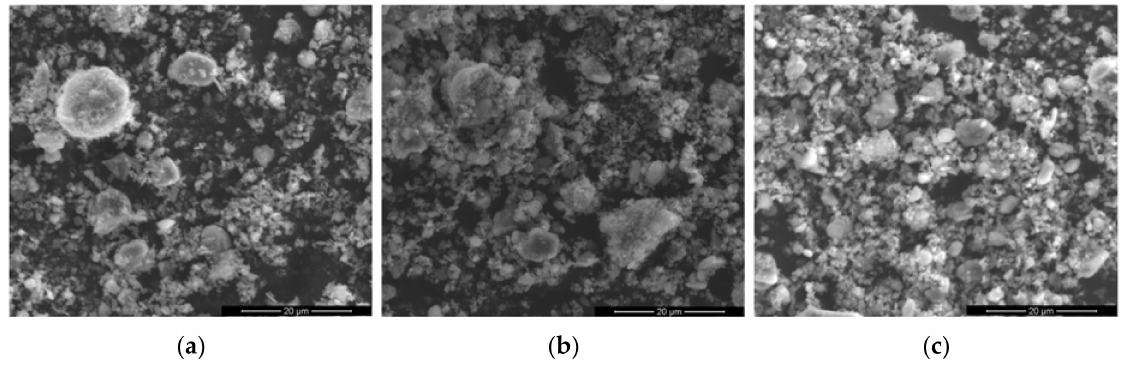
Figure 7. SEM images of the studied samples: ( a ) sample 1; ( b ) sample 2; and ( c ) sample